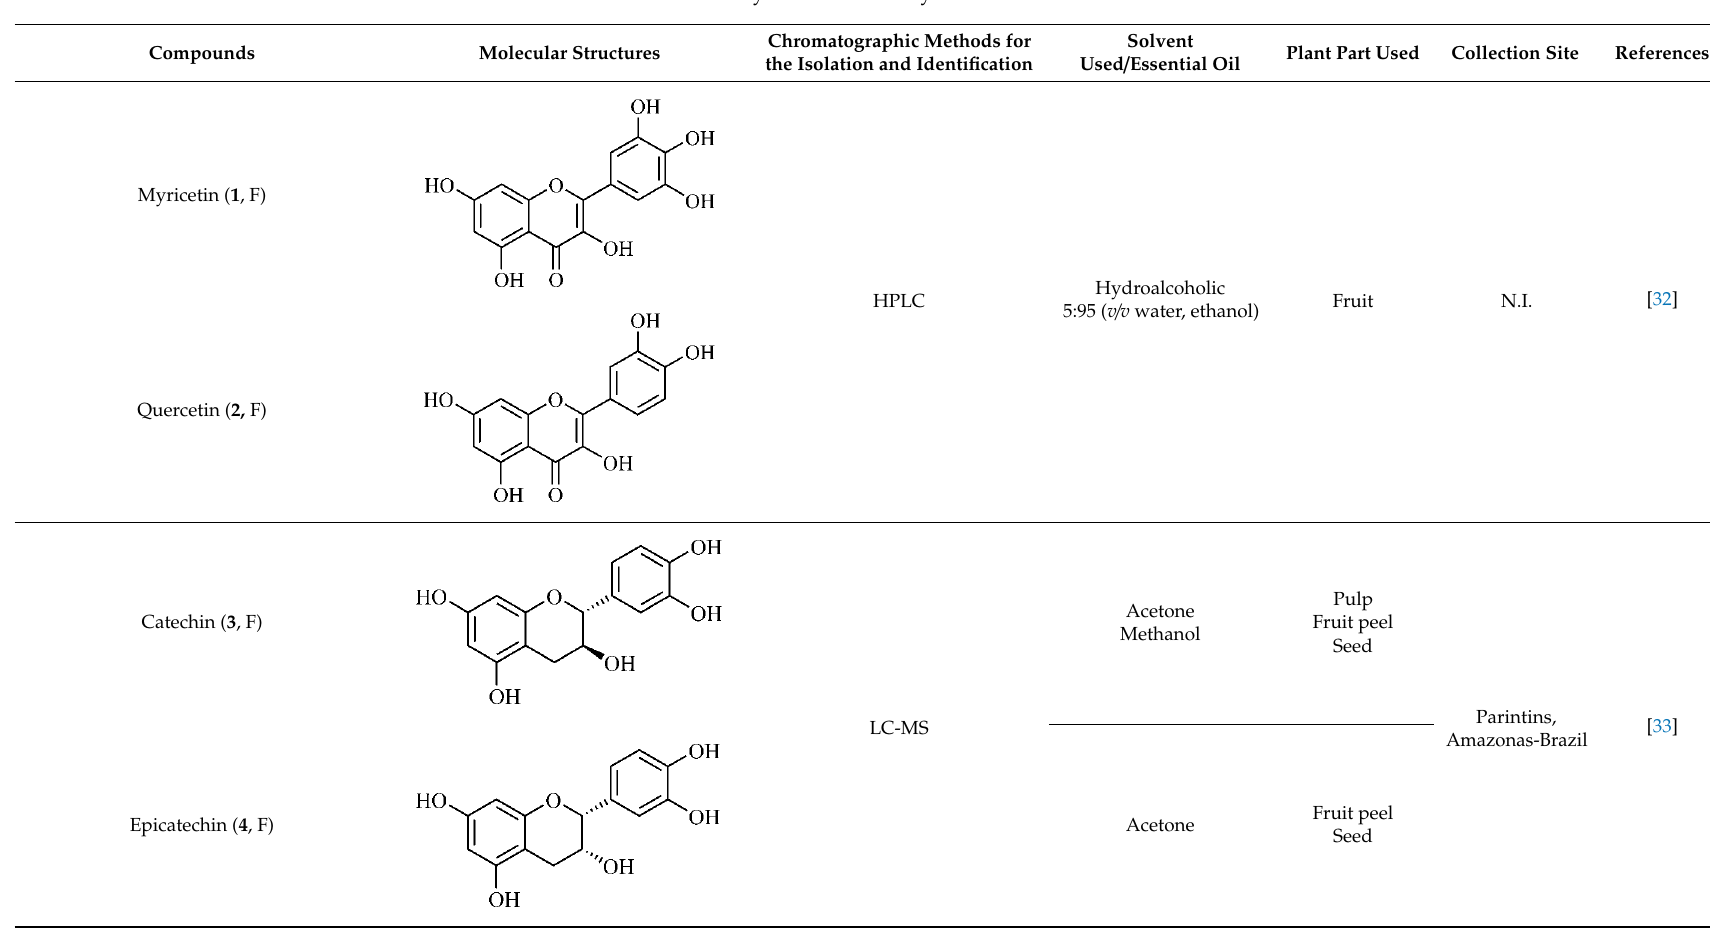
Table 1. Phytochemical analysis of T. esculenta .